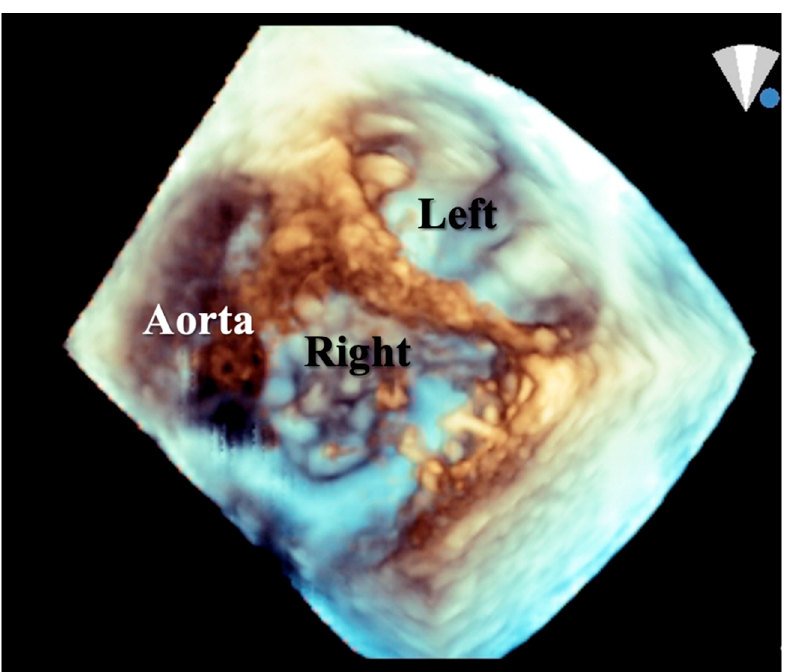
Figure 6. Short axis 3D echocardiographic section in a heart with AVSD and two valve orifices.